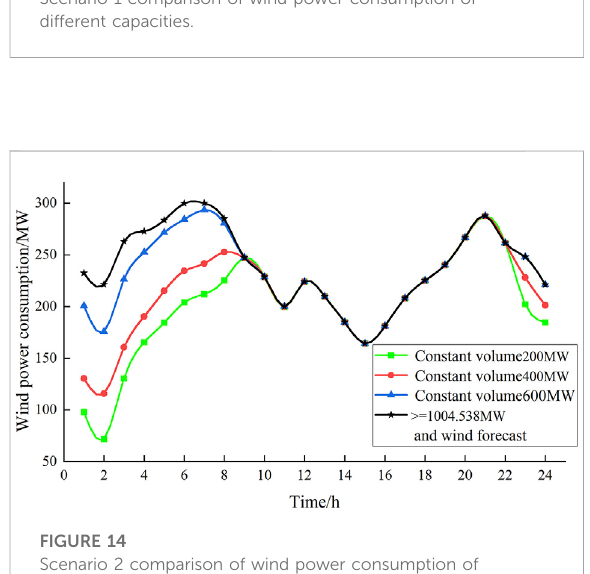
FIGURE 14 Scenario 2 comparison of wind power consumption of different